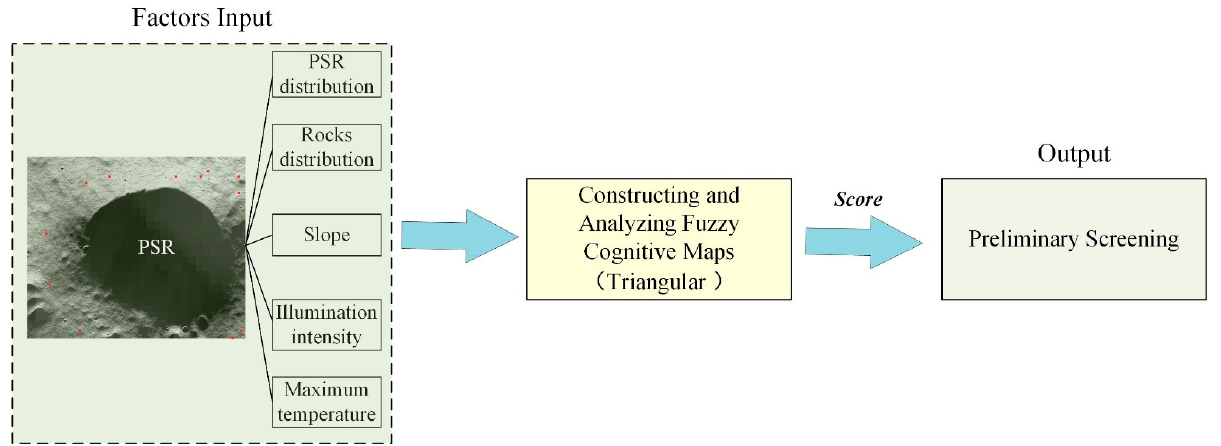
Figure 11. Schematic diagram of FCM algorithm application for site selection.